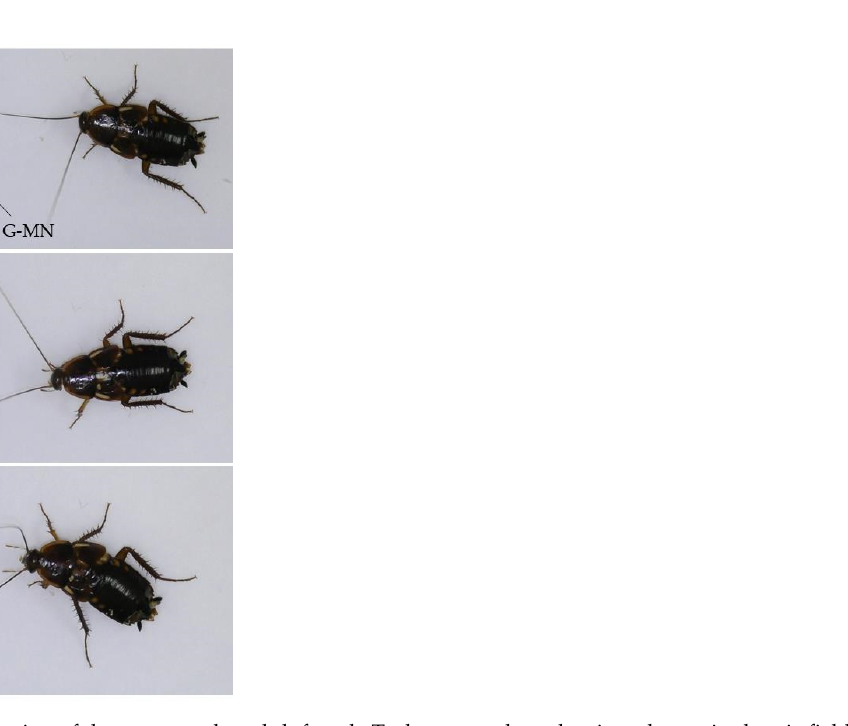
Figure 3. Insertion of the antennae by adult female Turkestan cockroaches into the static electric field (S-EF) of the S-EFP charged with − 6.0 ( A ), − 4.9 ( B ) and − 4.5 kV ( C ). The arrow shows the distance the antenna inserted from the grounded metal net (G-MN).